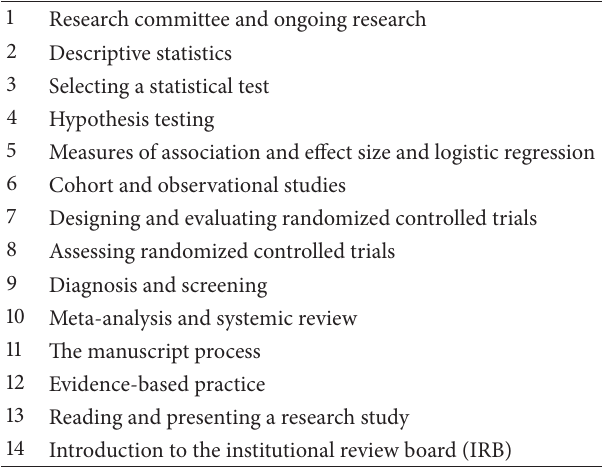
Table 1: Didactic topics in the intern research